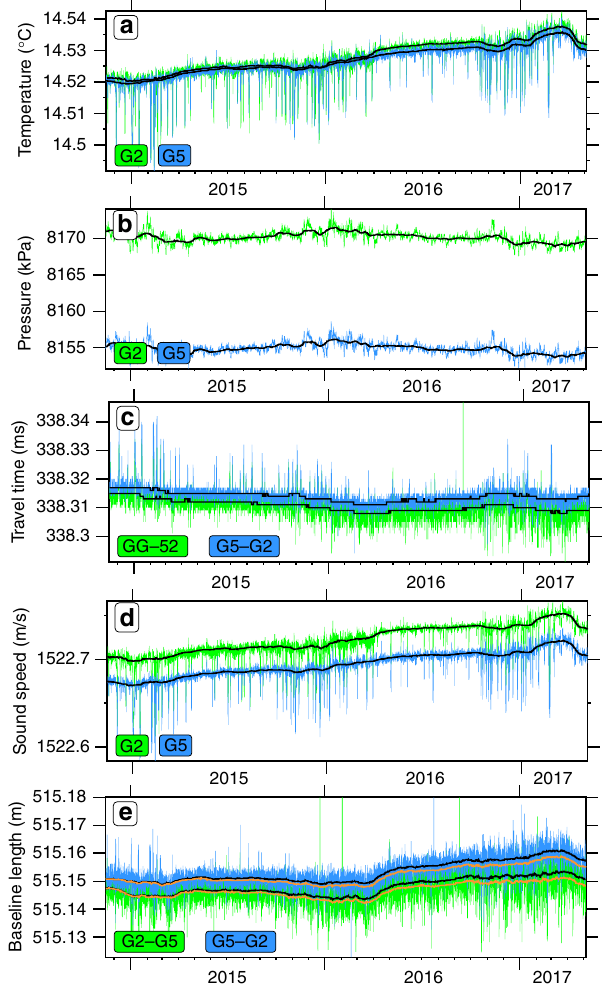
Fig. 3 Measured parameters and estimated baseline for station pair G2-G5. Black lines indicate monthly medians. a Temperature. b Pressure. c Acoustic one-way travel times between the transponders for the forward- and backward measurement. d Estimated sound speed from temperature and pressure (using a constant salinity). e Resulting baselines for both measurement directions. Orange lines indicate the monthly mean baseline lengths with the inferred linear salinity decrease rate of 0.002 PSU yr −